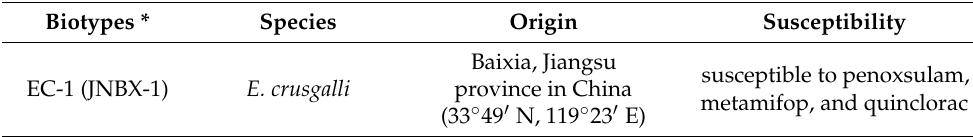
Table 1. Characteristics of the biotypes used to develop the RISQ